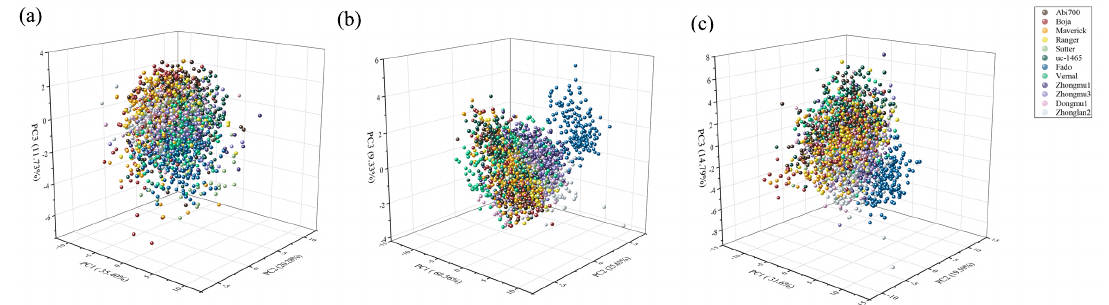
Figure 2. Three-dimensional plot of the first three principal components (PCs) for ( a ) morphological, ( b ) spectral and ( c ) morphological combined with spectral features dataset in 12 cultivars.